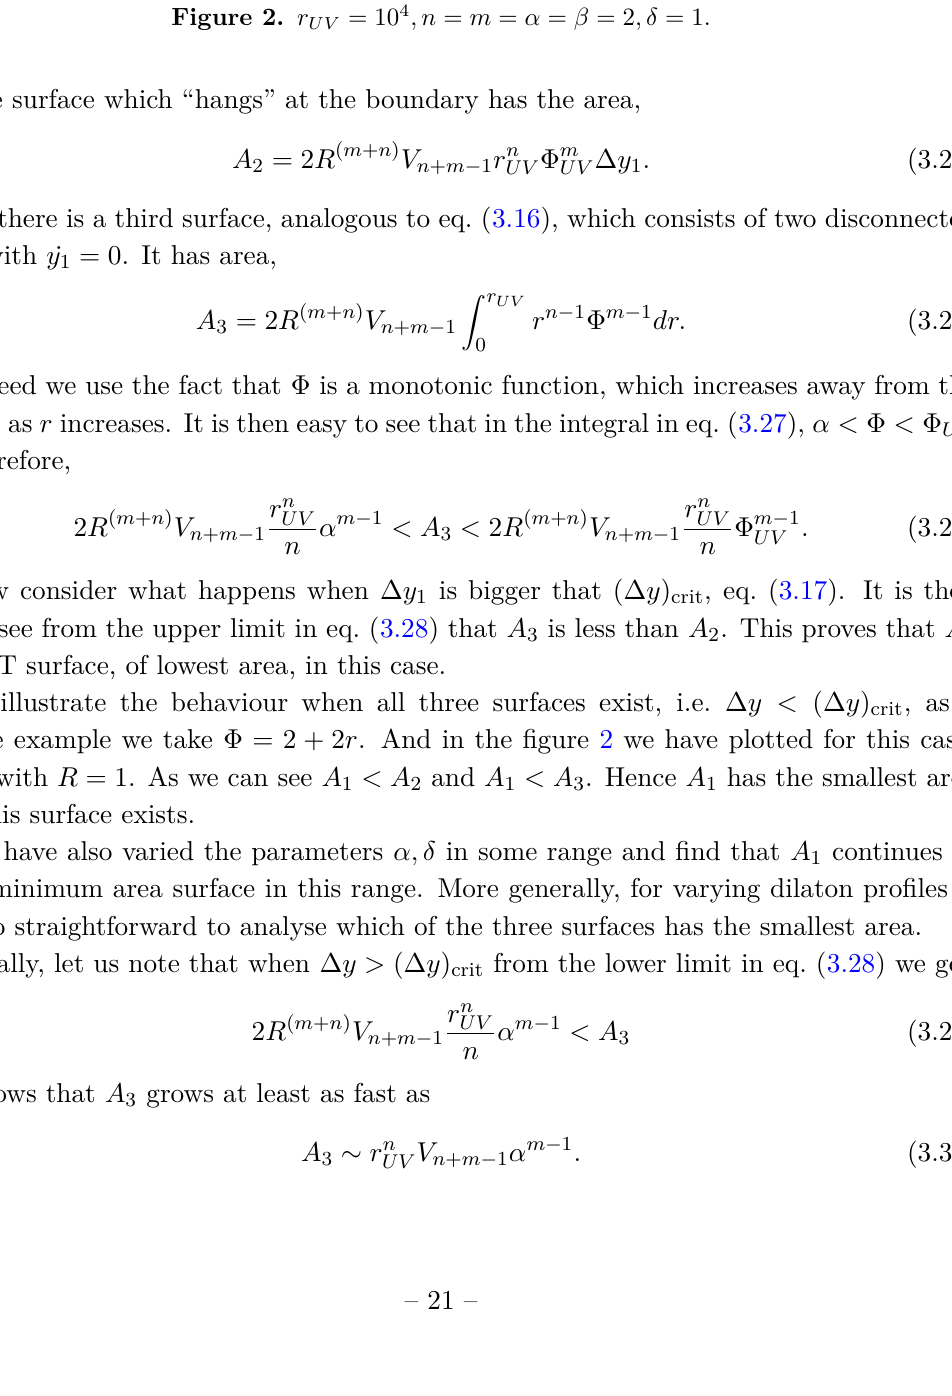
Figure 2. r UV = 10 4 , n = m = α = β = 2 , δ = 1